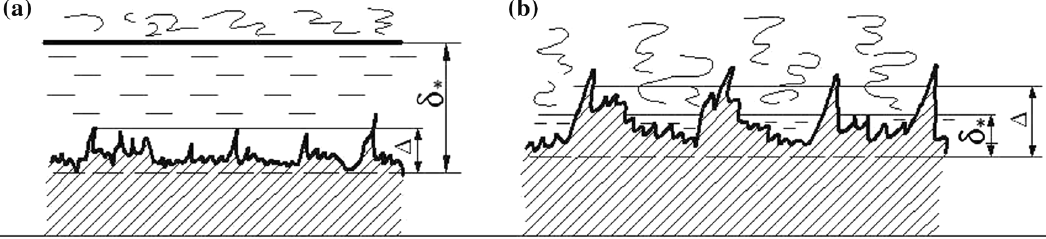
δ CT (m/s) and * = Δ/2 according to